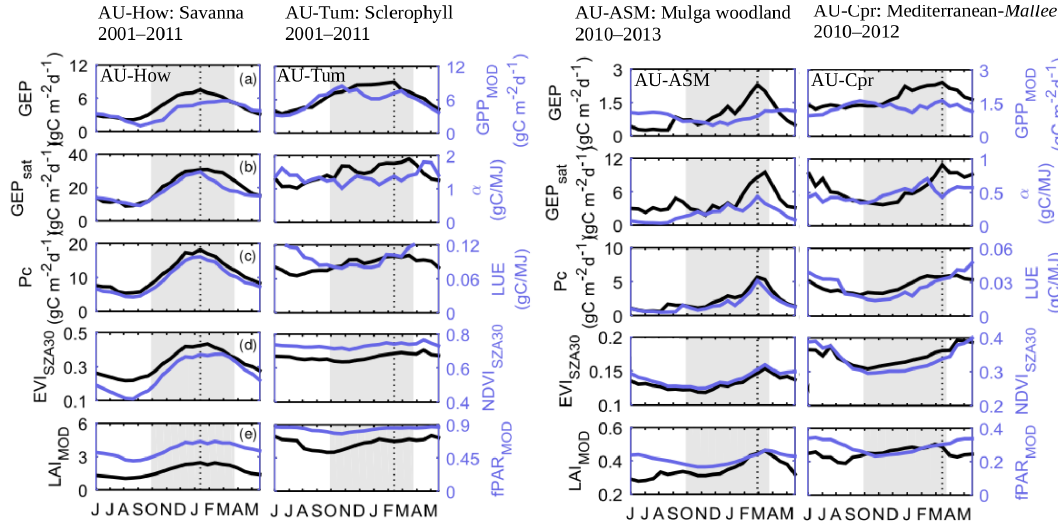
Figure 4. Savanna (AU-How), wet sclerophyll (AU-Tum), mulga (AU-ASM), and mallee (AU-Cpr) ecosystems, OzFlux sites annual cycle (16-day composites) of eddy-flux-derived (a) gross ecosystem productivity (GEP; gCm − 2 d − 1 ) (black line) and MODIS gross primary productivity (GPP MOD ) product (light blue line); (b) GEP at saturation light (GEP sat ; gCm − 2 d − 1 ) (black line) and ecosystem quantum yield ( α ; gCMJ − 1 ) (light blue line); (c) photosynthetic capacity (Pc; gCm − 2 d − 1 ) (black line) and the ratio of GEP over PAR (black line), the light use efficiency (LUE; gCMJ − 1 ) (light blue line). At the bottom two panels, satellite-derived data of (d) MODIS enhanced vegetation index at fixed solar zenith angle of 30 ◦ (EVI SZA30 ) (black line) and the normalized difference vegetation index (NDVI SZA30 ) (light blue line); (e) MODIS leaf area index (LAI MOD ) (black line) and MODIS fraction of the absorbed photosynthetic active radiation (fPAR MOD ) (light blue line). Grey boxes indicate Southern Hemisphere spring and summer September to March. The black dashed vertical line indicates the timing of maximum